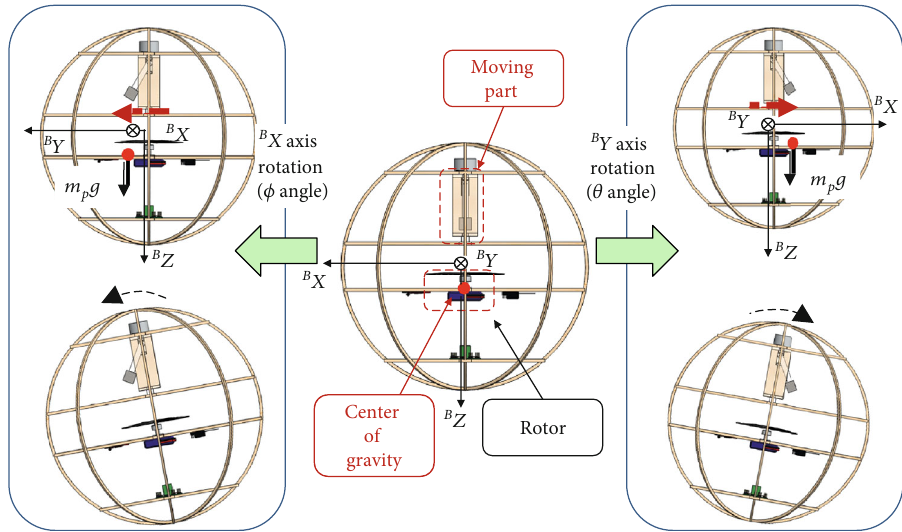
Figure 1: Operation concept using the suggested